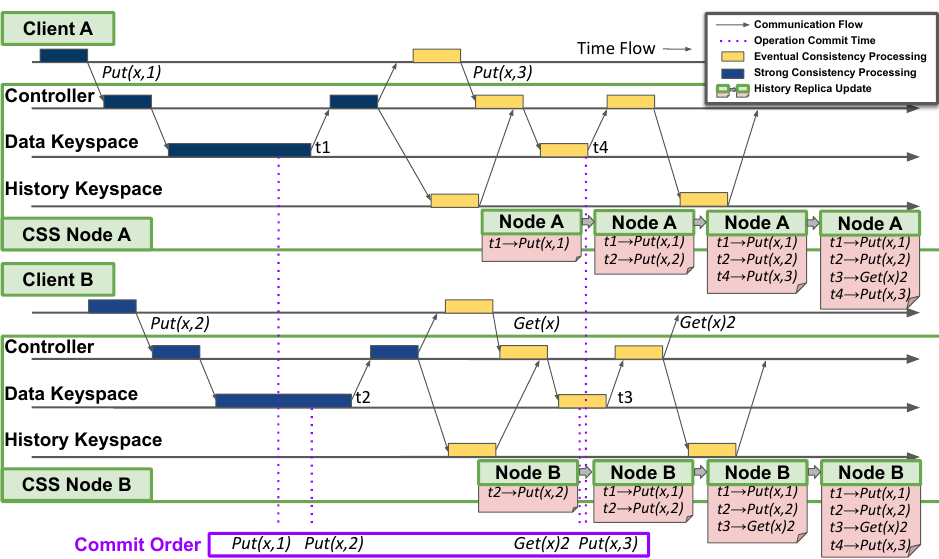
Figure 8. An Example Execution of Conflict-free History Replica Update. This figure shows how clients’ requests for operations are processed on CSS Nodes, recorded in the distributed history replicas in parallel and eventually merged into a totally ordered history reflecting commit order of operations. Also, note that history updates are executed in parallel and asynchronously by using eventually consistenty Puts to update the distributed history